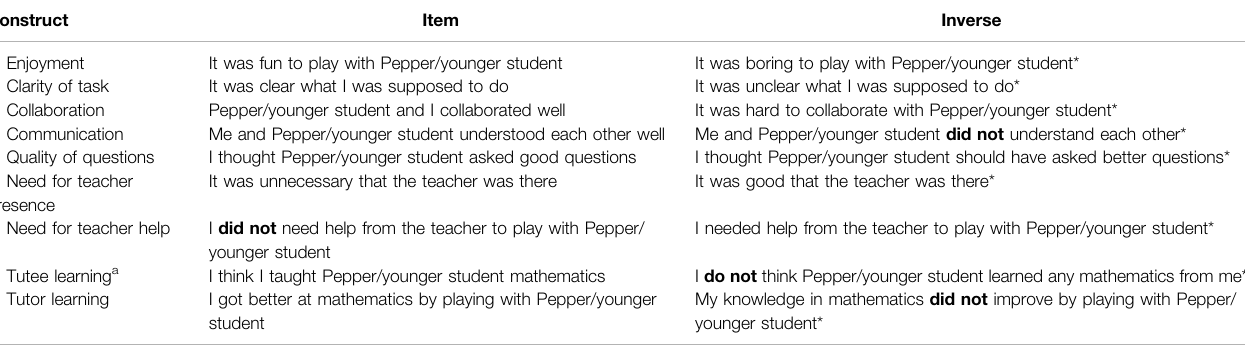
TABLE 1 | Items on the two evaluation questionnaires (RT = Pepper; CT = younger